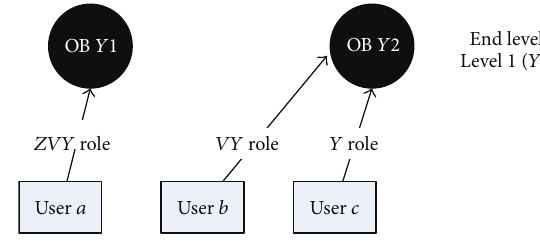
Figure6:RelationsbetweenusersandobjectsinthefinalFPSNafter the bottom-top flattening process.